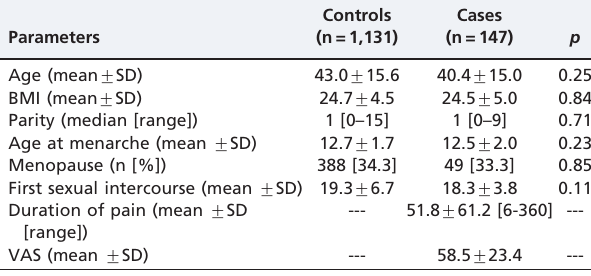
Table 1 - Characteristics of the subjects included in the present